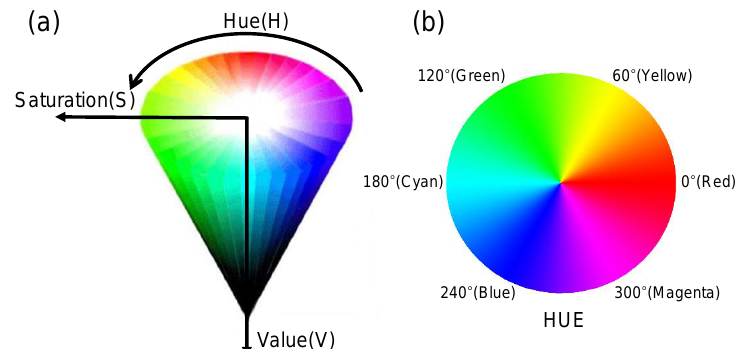
Figure 3. Representation of the HSV(hue, saturation, value), color space ( a ) schematic and ( b ) color circle in the hue domain.